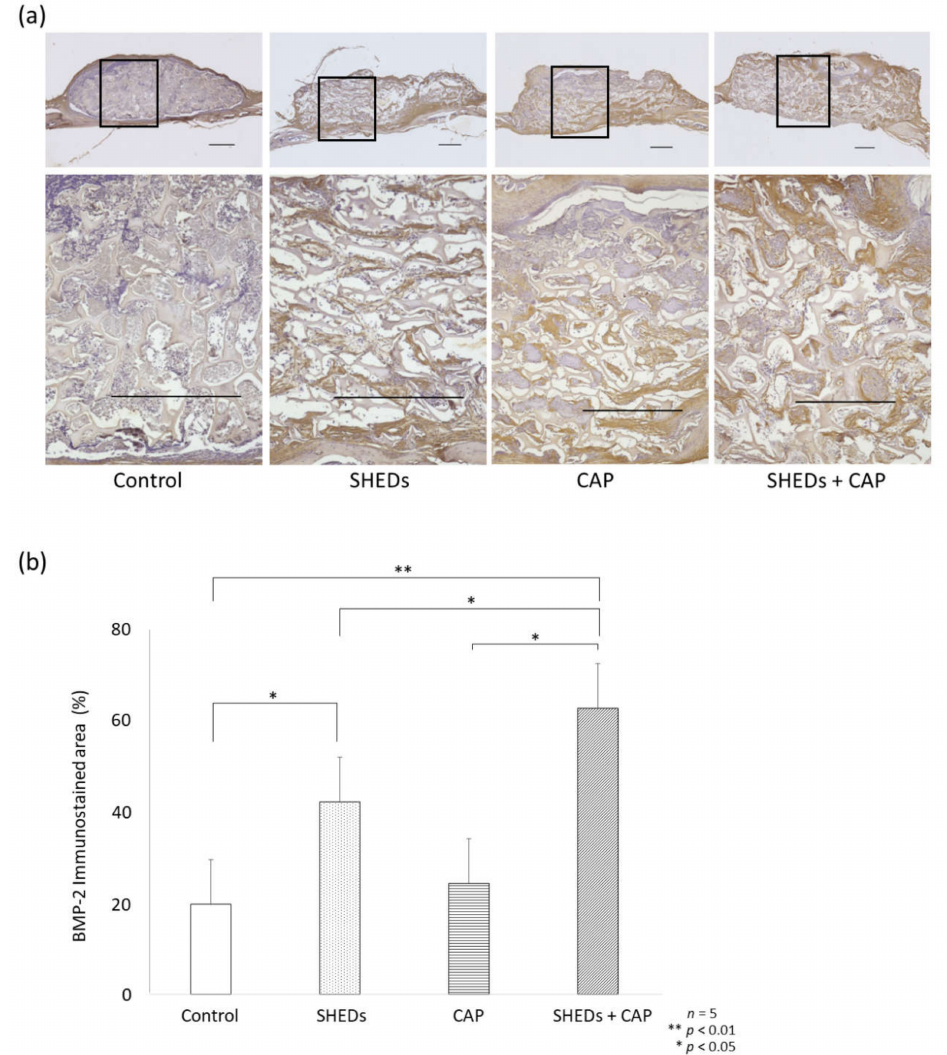
Figure 3. IHC analysis of the expression of BMP-2. ( a ) IHC analysis of BMP-2 expression showed that only a few sites of expression were observed in the control group but were more clearly observed in the other groups. ( b ) Statistical analysis of the stained area showed a significantly higher BMP-2 expression in the SHEDs and SHEDs + CAP groups but not in the control group or CAP group. n = 5 for each group, ** p < 0.01, * p < 0.05. Scale bars = 500 µ